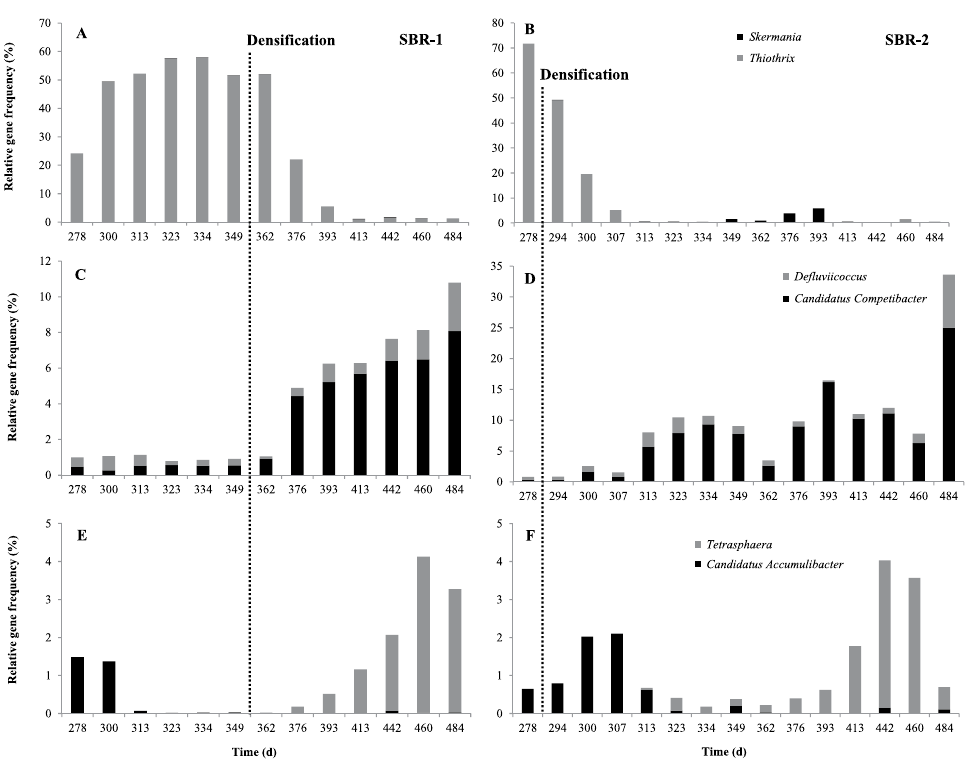
Figure 4. Temporal change in the relative gene frequency in SBR1 (left) and SBR2 (right) of Skermania spp. and Thiothrix spp. ( A and B ), Defluviicoccus spp. and Candidatus Competibacter ( C and D ), Tetrasphaera spp. and Candidatus Accumulibacter ( E and F